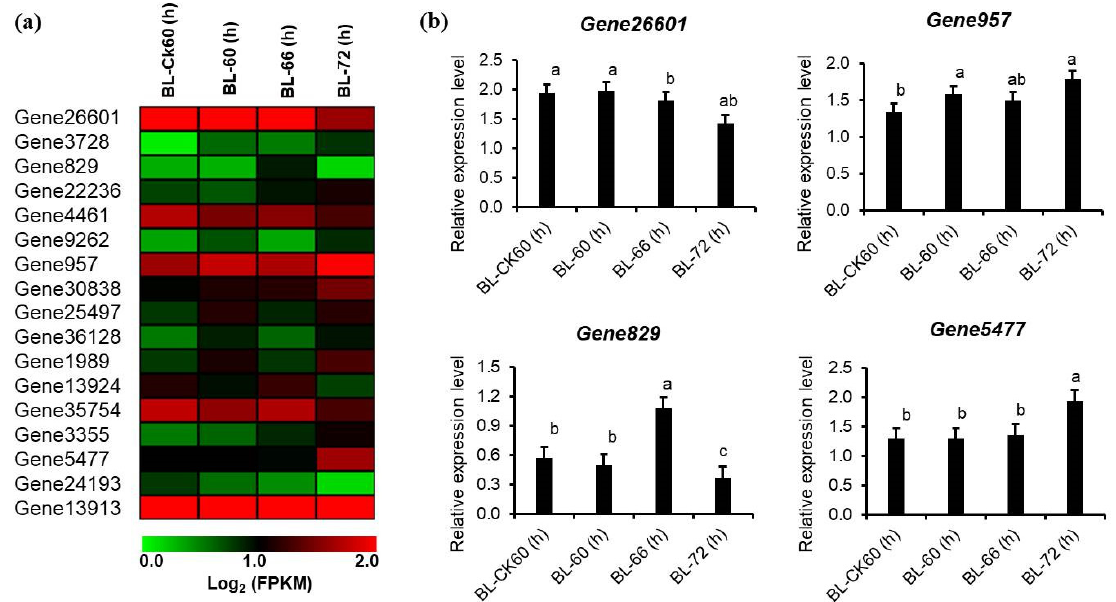
Figure 6. Expression profiling of plant hormone signal transduction DEGs in the hypocotyl of R. pseudoacacia -148 during adventitious root formation; ( a ) Heat map illustration of log2 (FPKM) values for annotated genes during hormone signal transduction pathway; ( b ) Relative expression of hormone transduction pathway genes as determined by RT-qPCR. The data presented are the average of three technical replicates. Different letters indicate significant difference by least significant difference (LSD) test ( p ≤ 0.05). Bar = SD.